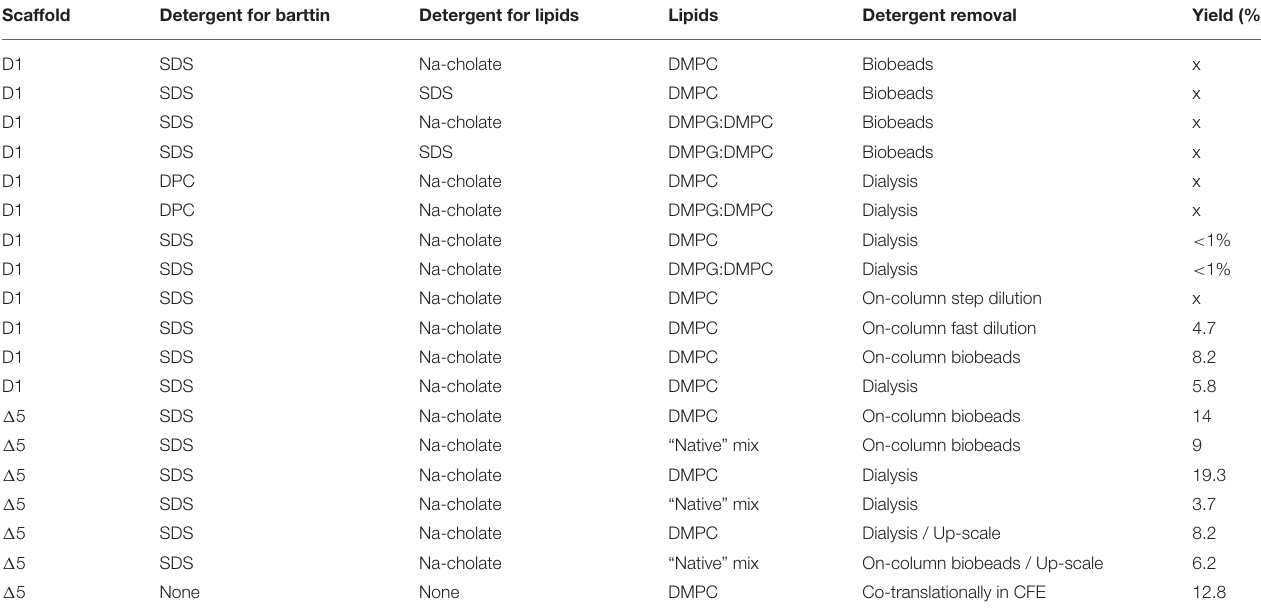
TABLE 1 | Summary of tested conditions for barttin reconstitution in NDs. Scaffold Detergent for barttin Detergent for lipids Lipids Detergent removal Yield (%)